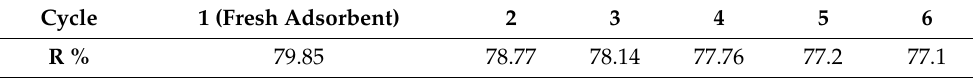
Table 8. The removal efficiency of cations from brackish water over fresh and exploited adsorbent. Cycle